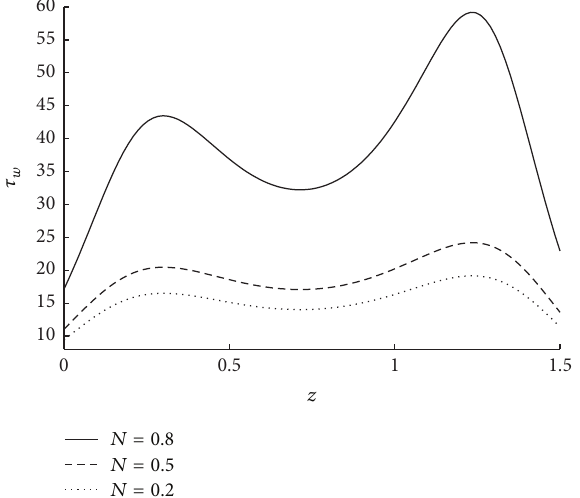
Figure 15: The variation of shear stress at wall in stenosed region with respect to 𝑁 when 𝑟 𝑐 = 0.1 , 𝜖 = 0.1 , 𝑢 = 0.01 , 𝑚 = 10 , and 𝜙 = −0.05 .